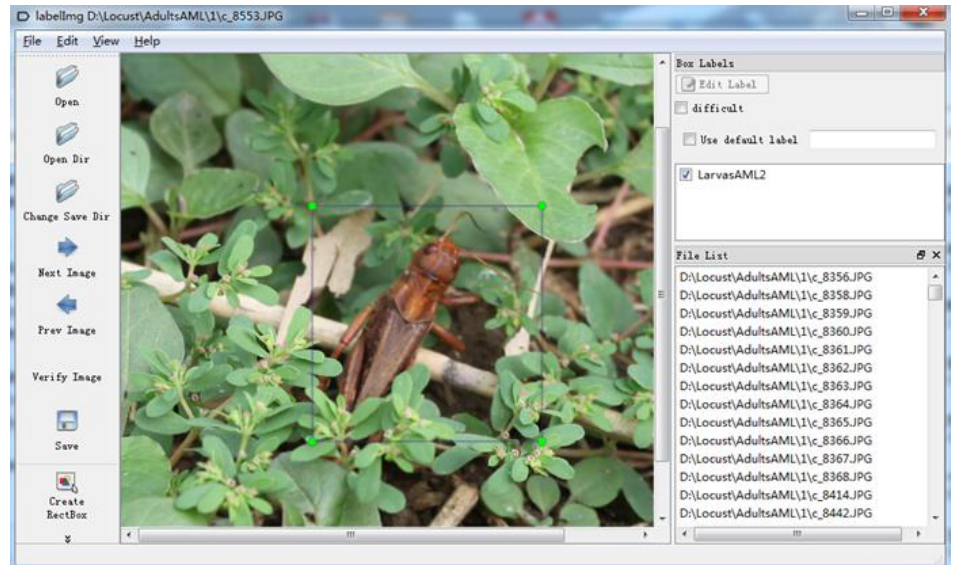
Figure 1. Schematic diagram of sample annotation based on lableImg.